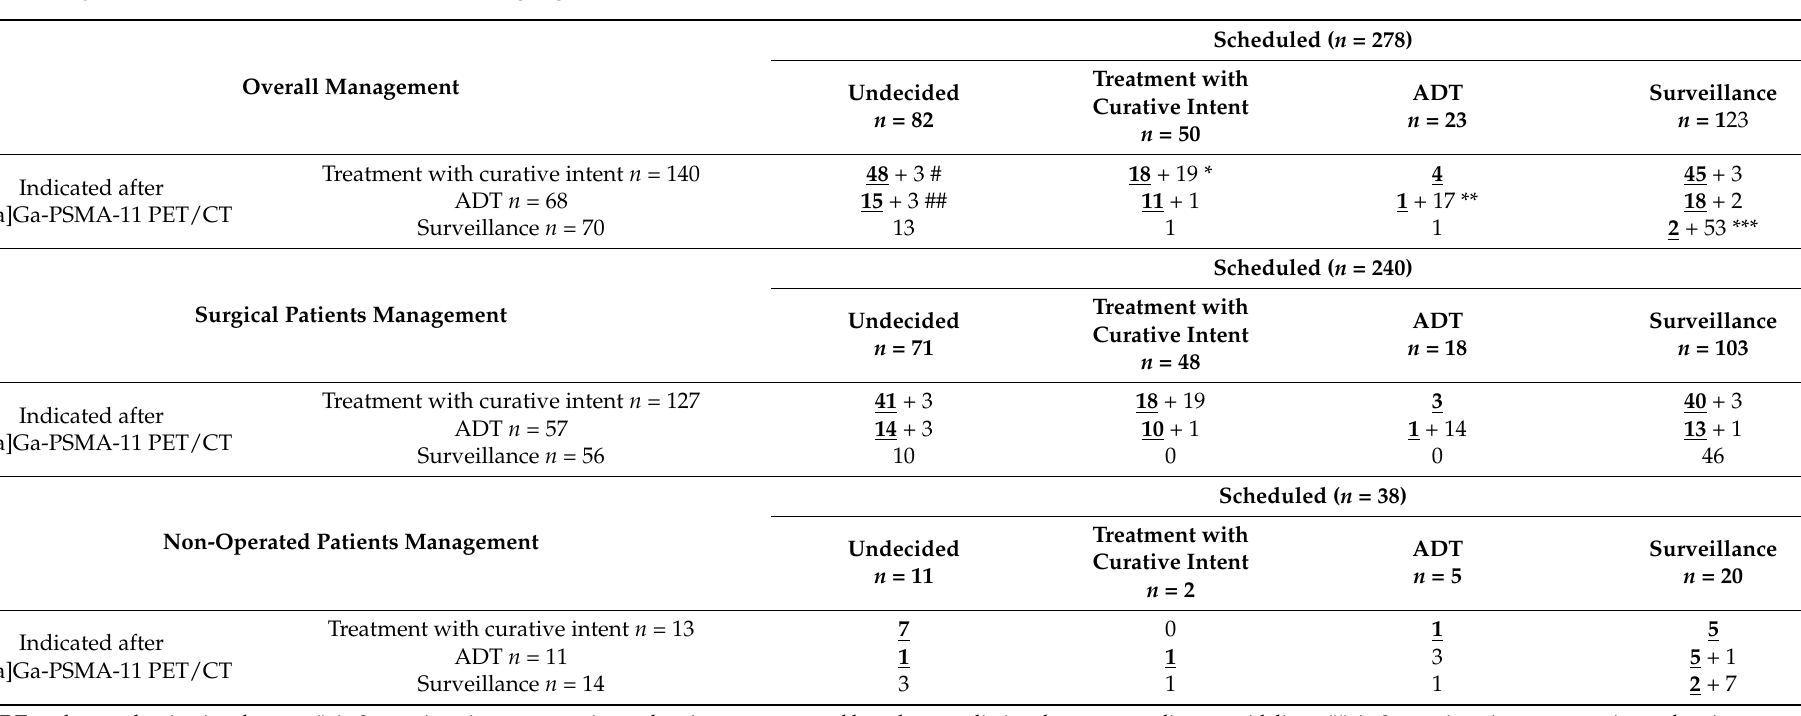
Table 4. Impact on patient management. Management scheduled before and in view of [ 68 Ga]Ga-PSMA-11 PET/CT, overall, for surgical patients and for non-operated patients. Changes induced by [ 68 Ga]Ga-PSMA-11 PET/CT results are highlighted in bold and